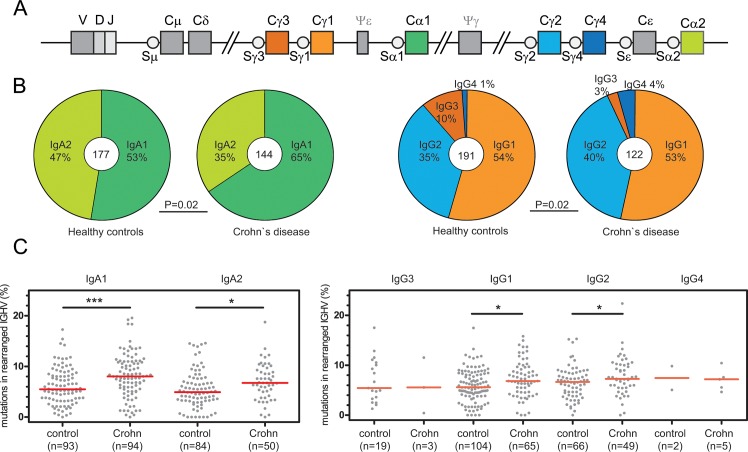
IgA and IgG subclass analysis.A, Schematic representation of the constant region of the human IGH locus. B, Distribution of IgA and IgG subclass use in switched transcripts of healthy controls and patients with Crohn’s disease. Total numbers of analyzed sequences are indicated in the middle of the plots. χ2 Test was performed to analyze differences in distributions. C, Combined IGHV mutation frequencies in IgA and IgG transcripts in patients and controls (total numbers of sequences indicated between brackets). Grey dots represent unique sequences; red lines represent median values. Statistical analysis was performed with the Mann-Whitney test; *, P<0.05; **, P<0.01; ***, P<0.001.